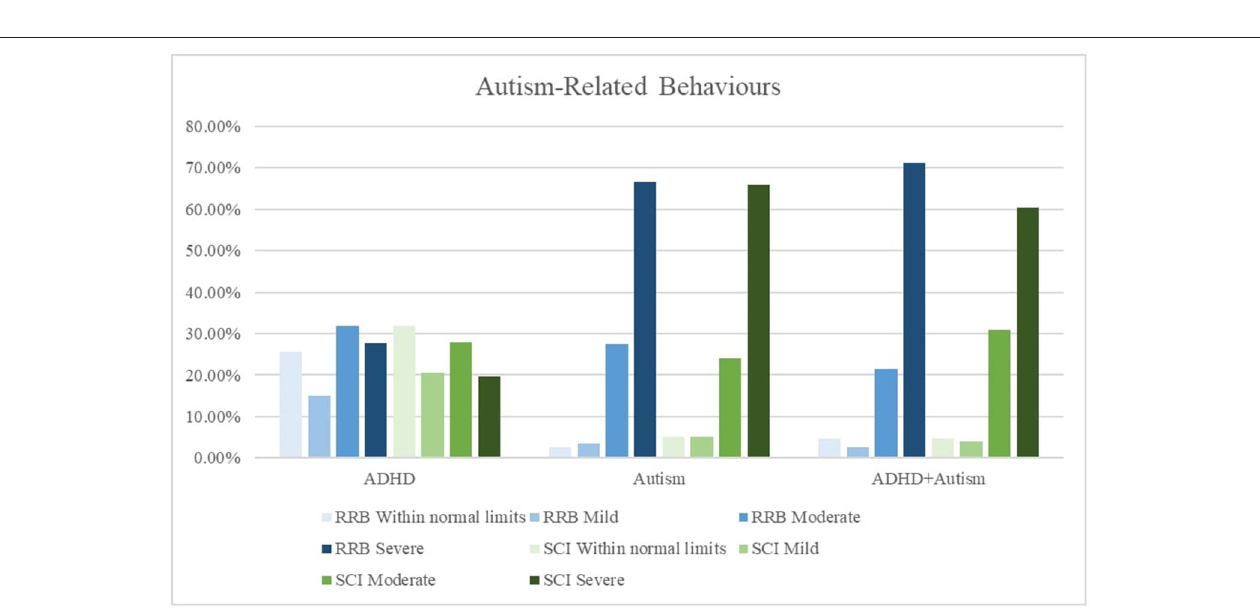
FIGURE 3 | Graphical summary of the autism symptoms stratified by diagnosis and restrictive repetitive behaviors (RRB) and social communication issues (SCI). The SRS-2 descriptors relate to the standardized scoring as follows, ≤ 59 = Within normal limits , 60–65 = Mild , 66–75 = Moderate , 76 ≥ = Severe . CPRS, Conners’ Parent Rating Scale-Revised Long form. Inattentive, subscale. Hyperactive, Hyperactive-impulsive subscale; SRS-2, Social Responsiveness Scale-2nd Edition; RRB, restrictive and repetitive behaviors; SCI, social communication index.